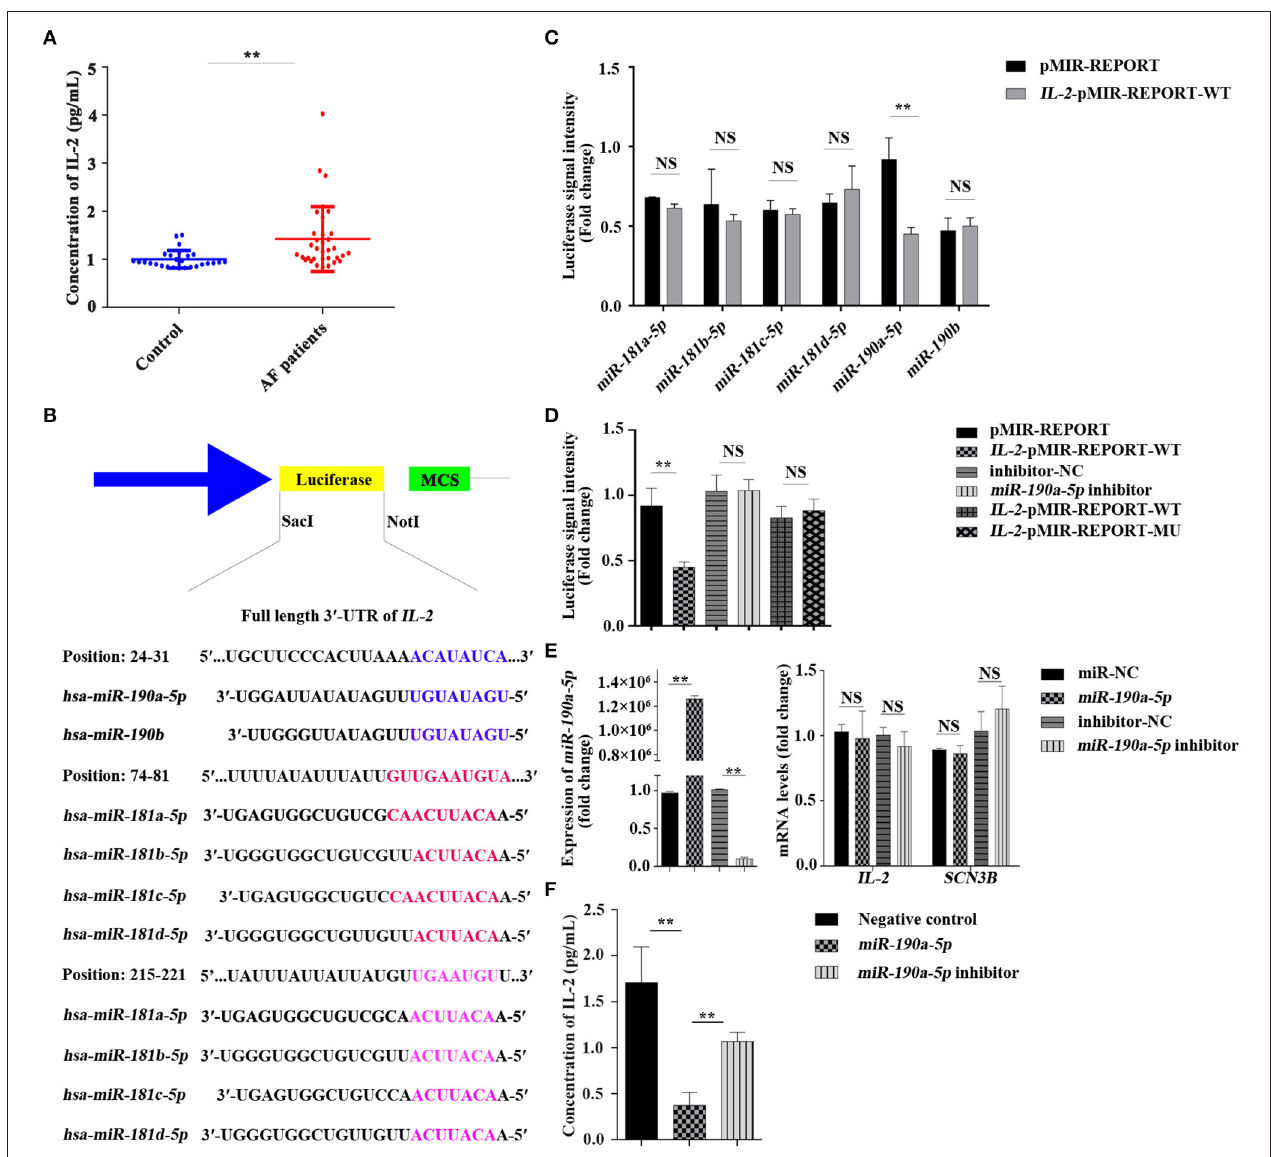
FIGURE 1 | Concentration of interleukin-2 (IL-2) in the peripheral blood serum of patients with atrial fibrillation (AF) was increased and IL-2 was negatively regulated by miR-190a-5p . (A) Level of IL-2 was increased in the peripheral blood serum of patients with AF than that of the normal control group (** p < 0.01 vs . control group). (B) The binding sites of miR-181 and miR-190 families in the 3’-untranslated region (UTR) of IL-2 . (C,D) Relative luciferase signal intensity in HEK293 cells (NS, no significant difference, ** p < 0.01 vs . pMIR-REPORT). (E) Relative expression of miR-190a-5p , IL-2 , and sodium voltage-gated channel beta subunit 3 ( SCN3B ) in AC16 cells transfected with miR-190a-5p mimic/inhibitor or miR-NC/inhibitor-negative control (NC) (** p < 0.01 vs . miR-NC, NS vs . inhibitor-NC). (F) Concentration of IL-2 in culture medium of AC16 cells treated with miR-190a-5p mimic/inhibitor or Negative control (NC) (** p < 0.01 vs . NC, ** p < 0.01 vs . miR-190a-5p ). Data are represented as means ±